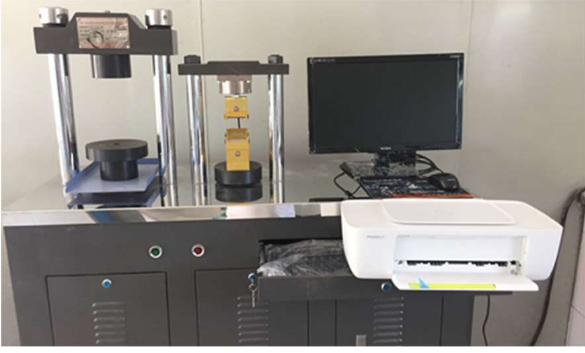
Figure 8. Cement mortar flexural/compressive tester